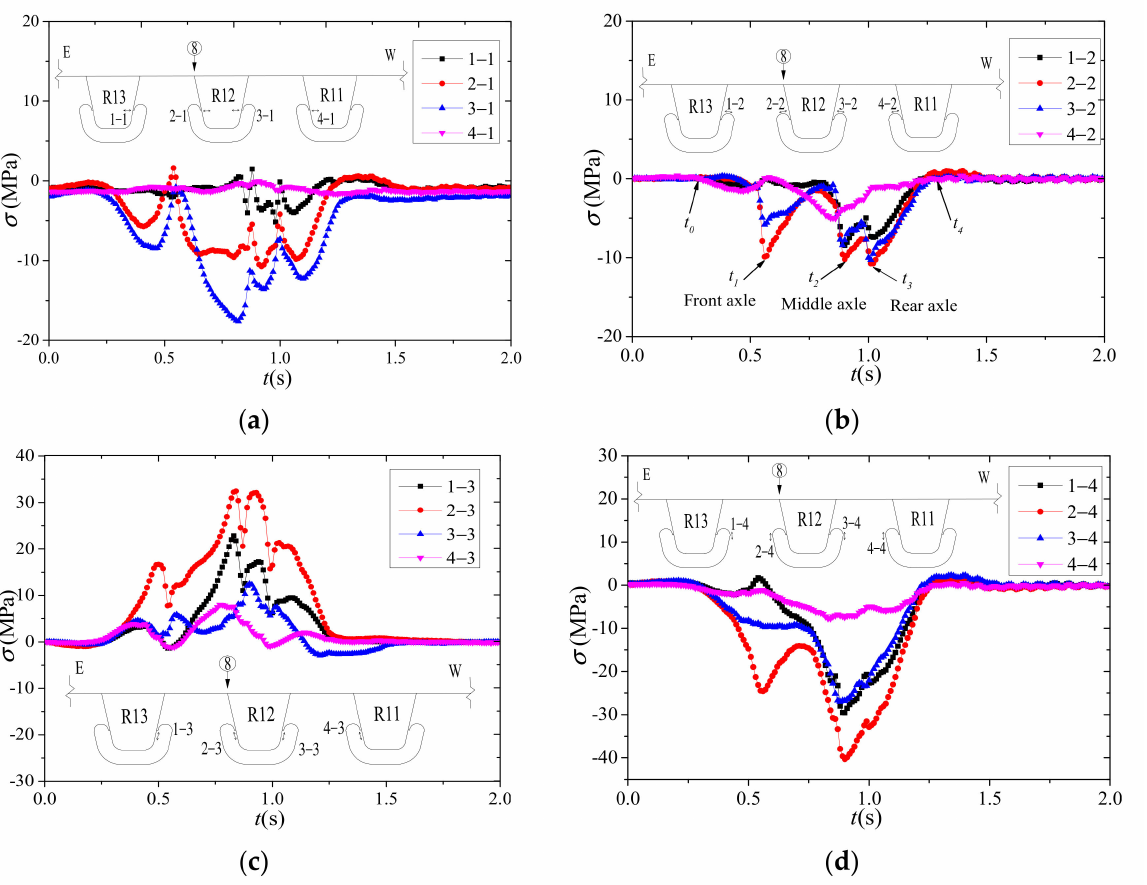
Figure 12. Stress records of the four details under the passage of the truck with intermediate